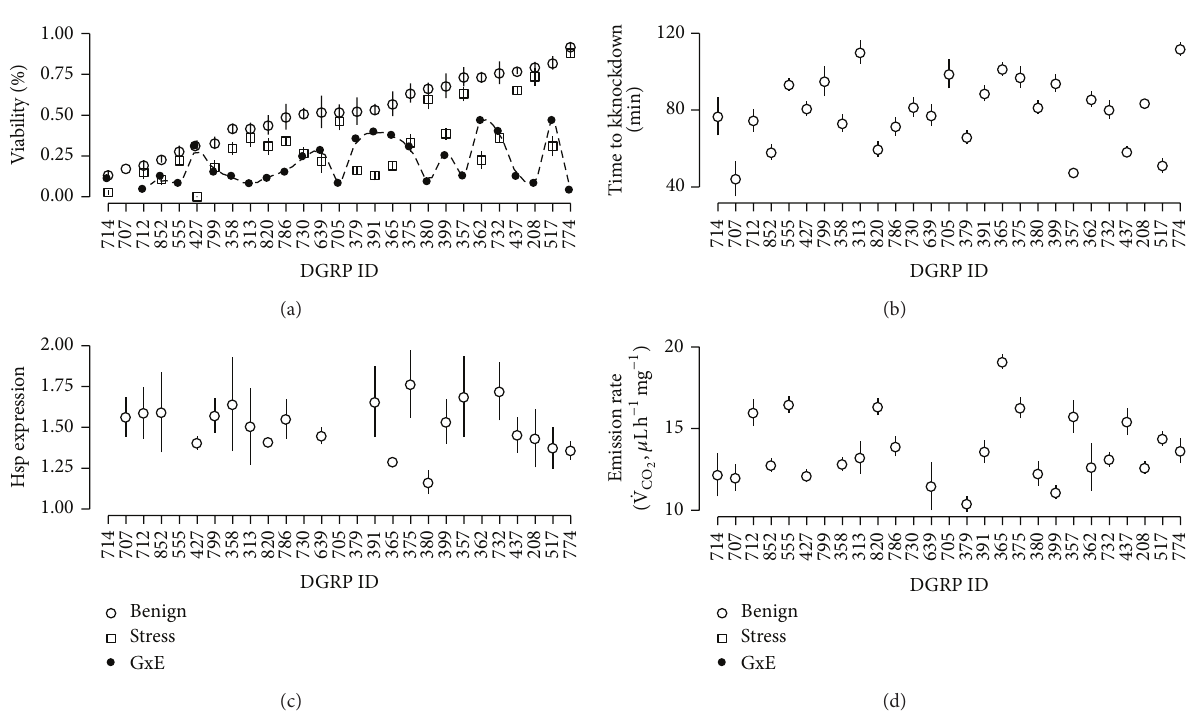
Figure 1: Distribution of DGRP phenotypes for the five assayed traits. Each panel shows the mean phenotypic value (error bars indicate standard error) for each assayed DGRP line. Lines are ordered after increasing egg-to-adult viability at benign condition. (a) Egg-to-adult viability expressed in percentage at benign condition (circles) and at lightly stressful condition (squares). Black dots indicate the difference in viability between the two environments, genotype-by-environmental interaction (GxE); (b) time to heat knockdown (min); (c) Hsp70 expression; and (d) metabolic rate measured as CO 2 emission